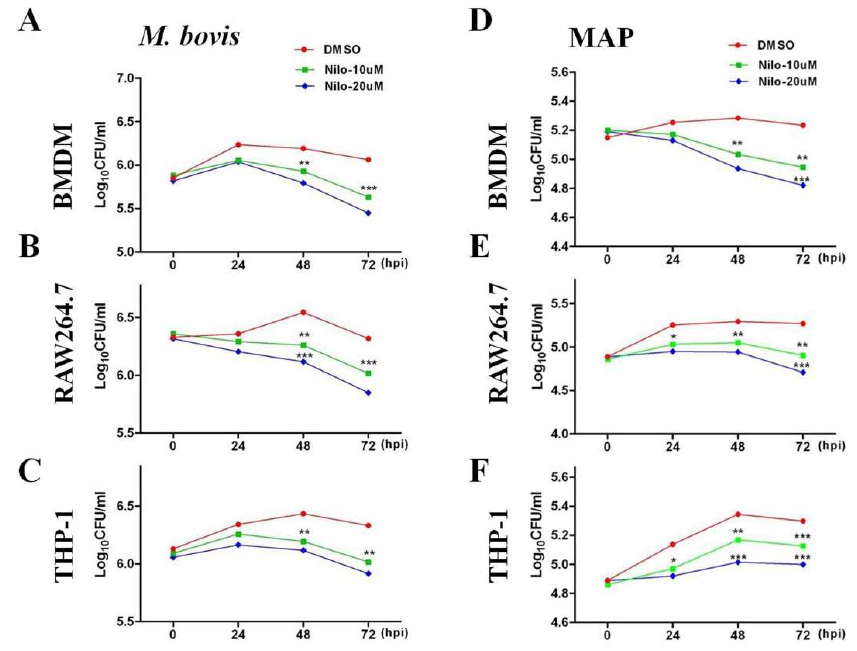
Figure 1. Nilotinib inhibits the intracellular survival of M. bovis and Mycobacterium avium subspecies paratuberculosis (MAP) in vitro. ( A , D ) BMDM, ( B , E ) RAW264.7 and ( C , F ) THP-1 cells were treated with DMSO (0.1%) or nilotinib 10 µ M and 20 µ M followed by infection with M. bovis and MAP for indicated time periods. Cells were lysed and intracellular survival of M. bovis and MAP was determined by performing Colony forming unit (CFU) assay. Mean ± SD were evaluated from three independent experiments. The data was analyzed by using two-way analysis of variance (ANOVA) followed by Bonferroni’s multiple comparison test. (* p < 0.05, ** p < 0.01, *** p < 0.001).